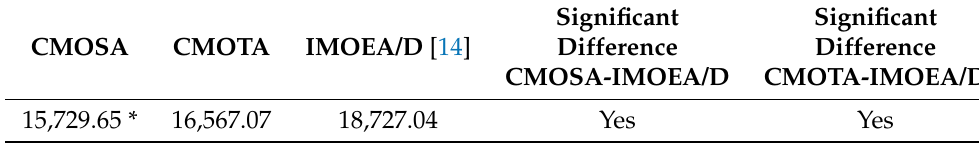
Table 8. CMOSA, CMOTA, and IMOEA/D results obtained using MID